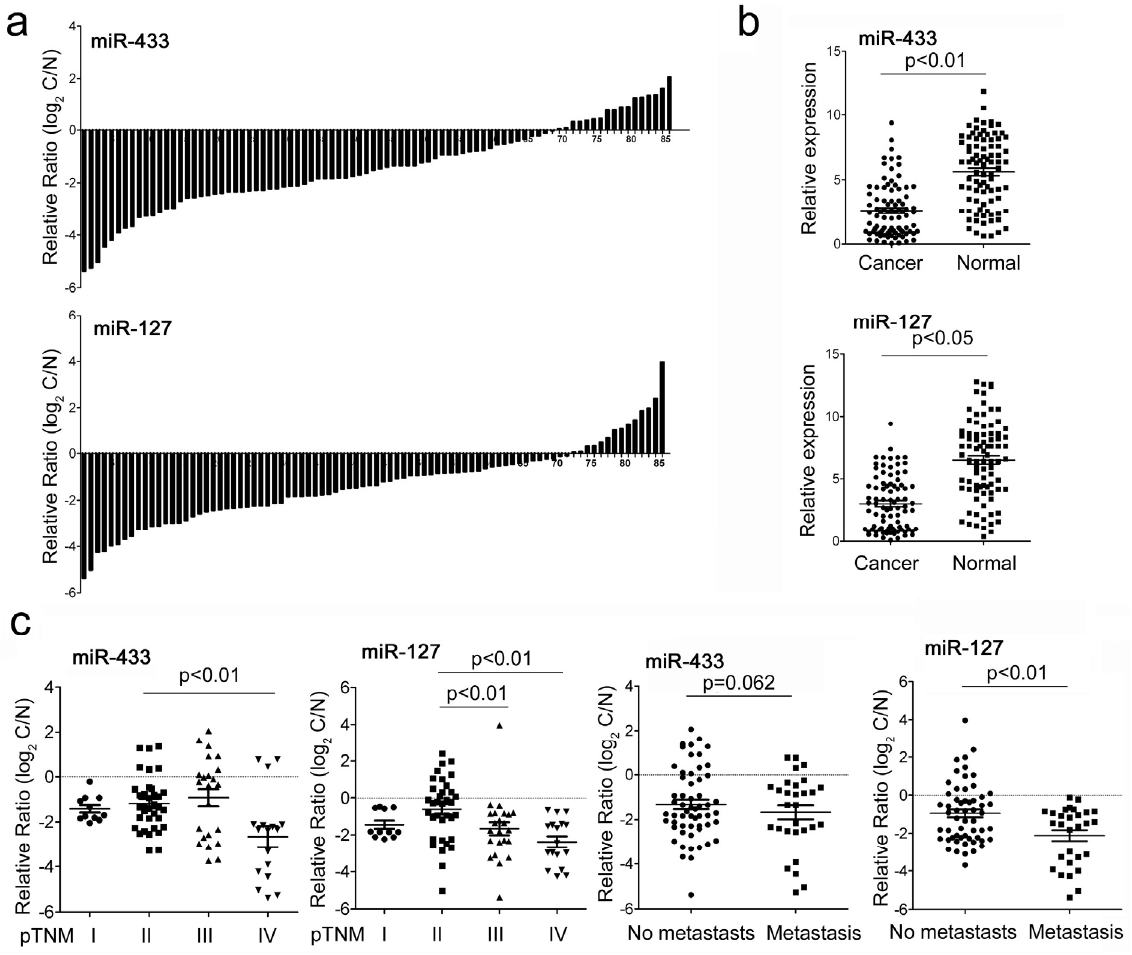
Figure 1. The expression of miR-433 and miR-127 in gastric cancer (GC) tissues and cell lines. ( a ) MiR-433 and miR-127 were detected in 86 pairs of GC tissues and its adjacent normal controls by quantitative RT-PCR. Data are presented as log2 of fold change of GC tissues relative to adjacent normal regions; ( b ) Relative miR-433 and miR-127 expression levels in GC tissues and adjacent normal regions; ( c ) The Statistical analysis of the association between miRNA level and pTNM stage (I, II, III and IV) and pM stage (No metastasis and Metastasis); ( d ) The relative level of miR-433 and miR-127 in GC cell lines (HGC-27,MGC-803, MKN-45 and SGC-7901) relative to four paired samples; ( e ) The expression of miR-433 and miR-127 in HGC-27 and MGC-803 cells after treatment with AZA,TSA or AZA and